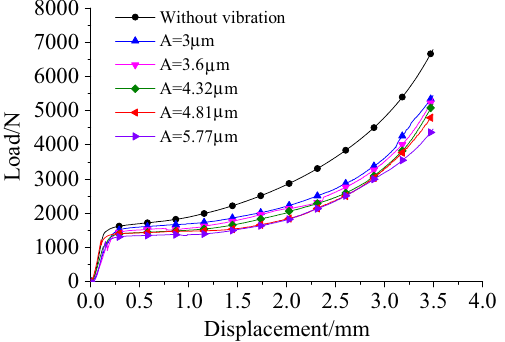
Figure 4. Load–displacement curves under different vibration conditions at 28 kHz frequency.